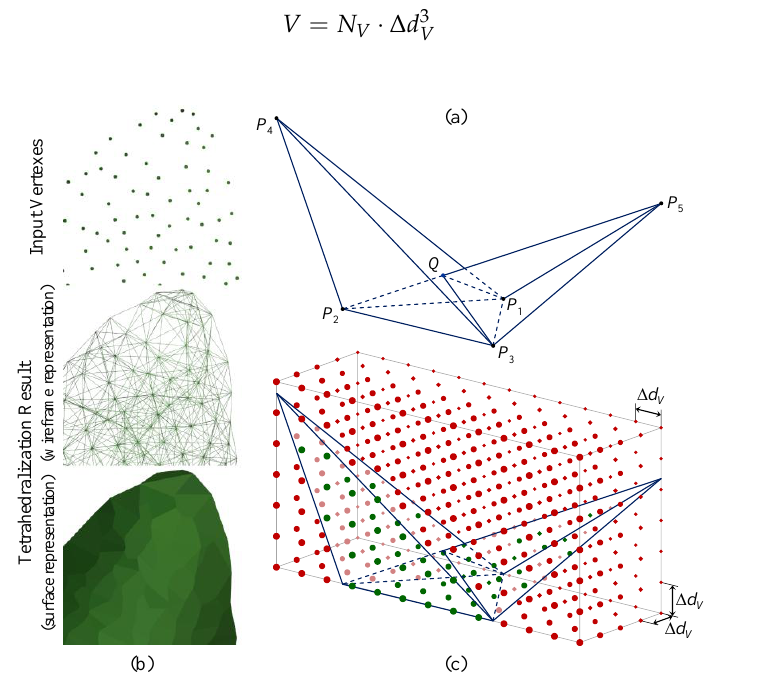
Figure 10. Principle of tetrahedralization and volume measurement: ( a ) overlapped tetrahedrons construction; ( b ) tetrahedralization result; ( c ) volume measuring principle. In ( c ), the points inside and outside the tetrahedrons are in green and red, respectively, and their sizes are differed by viewing distance (the farther the smaller).